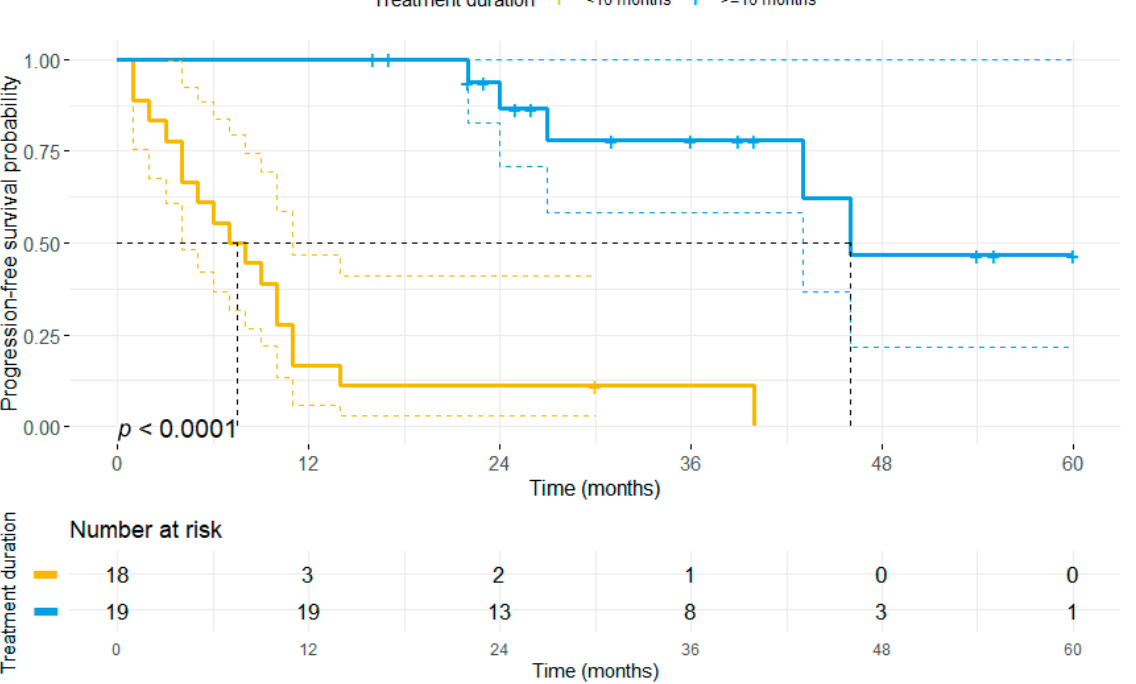
Figure 3. The duration of first-line BRAF ± MEKi therapy correlates with progression-free survival. The patient cohort was stratified based on the median duration of first-line BRAF ± MEKi treatment (16 months) in the entire study population. Patients who received first-line BRAF ± MEKi therapy for more than 16 months showed a significantly longer PFS (median: 46 months) as compared to patients receiving TT for a shorter time period (median PFS: 7 months).